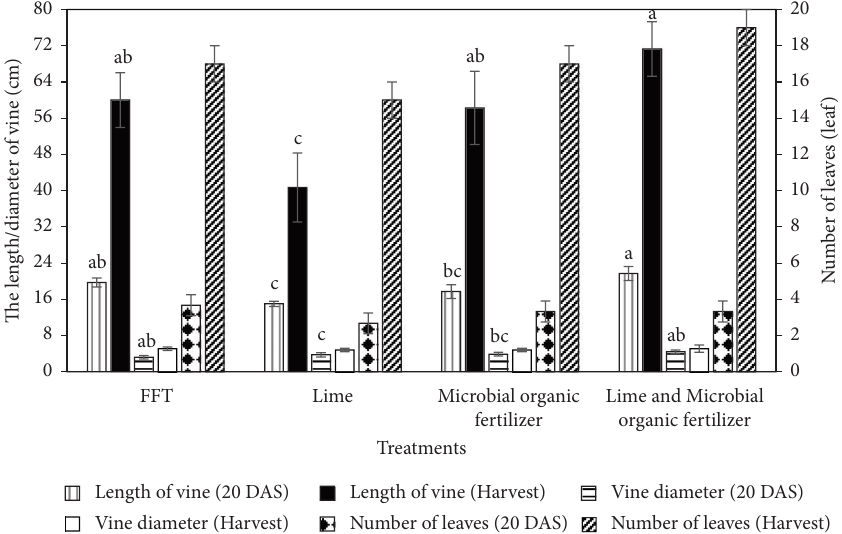
Figure 3: Vine length, vine diameter, and number of leaves of watermelon at 20 days after sowing and harvest time.